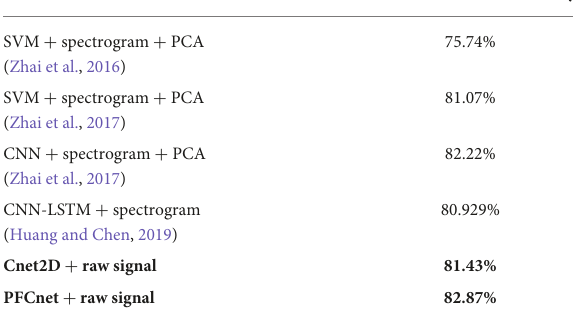
TABLE 6 Comparison of performance of proposed methods with state-of-the-art on Ninapro DB2 database with 17 movement classes (chance accuracy level =